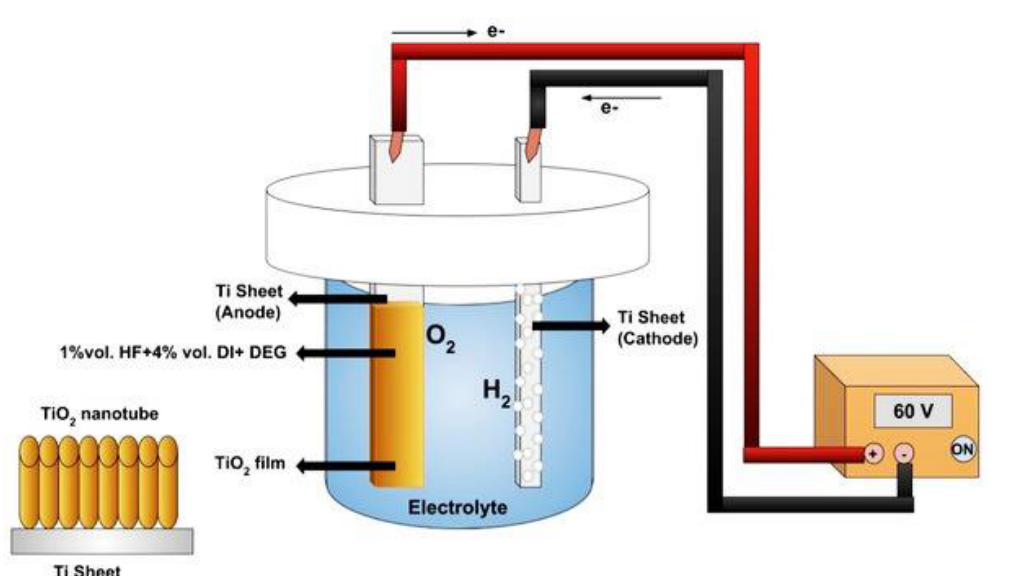
Figure 4. Illustration of electrochemical anodization process used to form TNTs, adopted from [51].